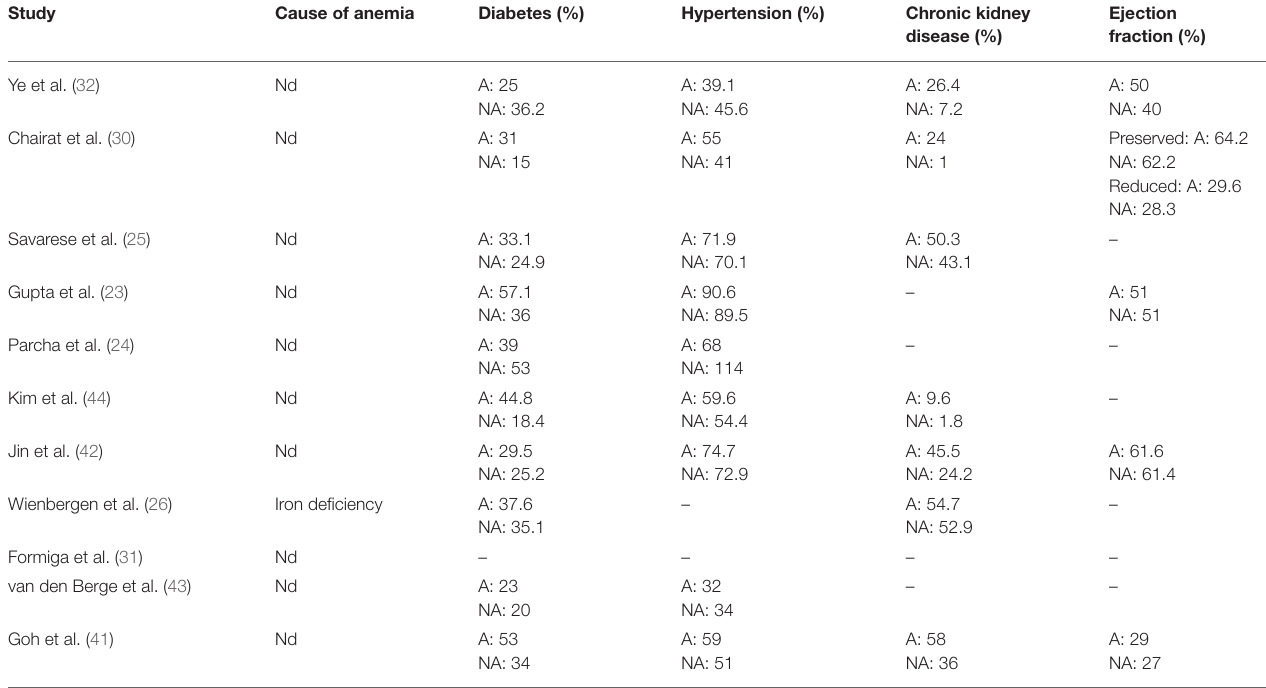
TABLE 2 | Clinical characteristics of the patients. Study Cause of anemia Diabetes (%) Hypertension (%) Chronic kidney